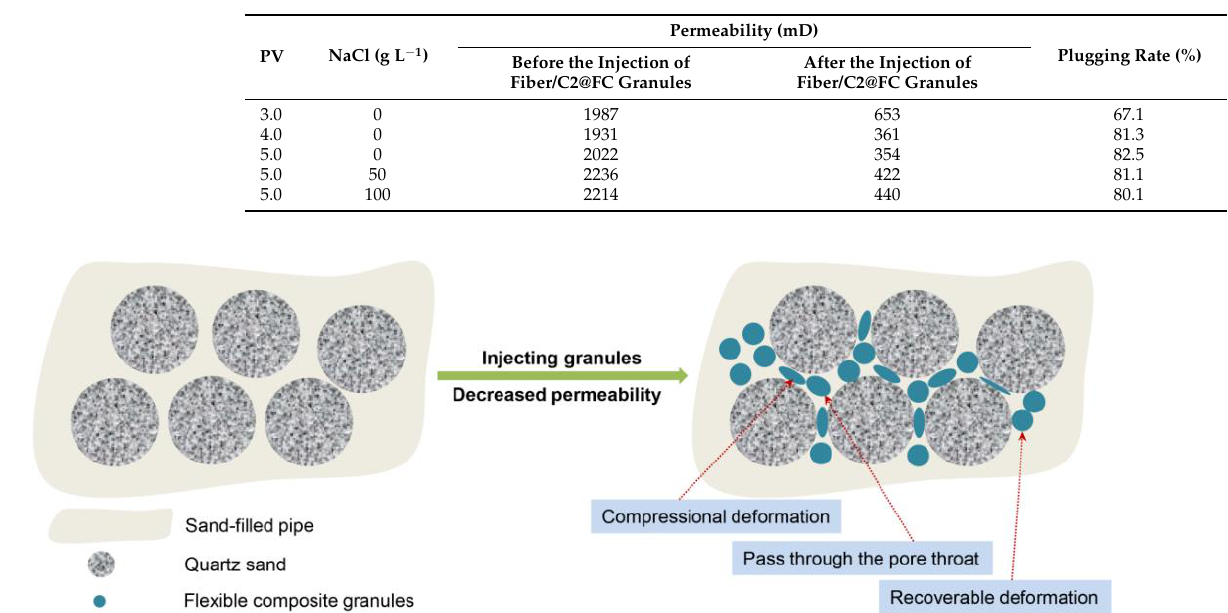
Table 2. Plugging rate of fiber/C2@FC granules with different injection volumes.